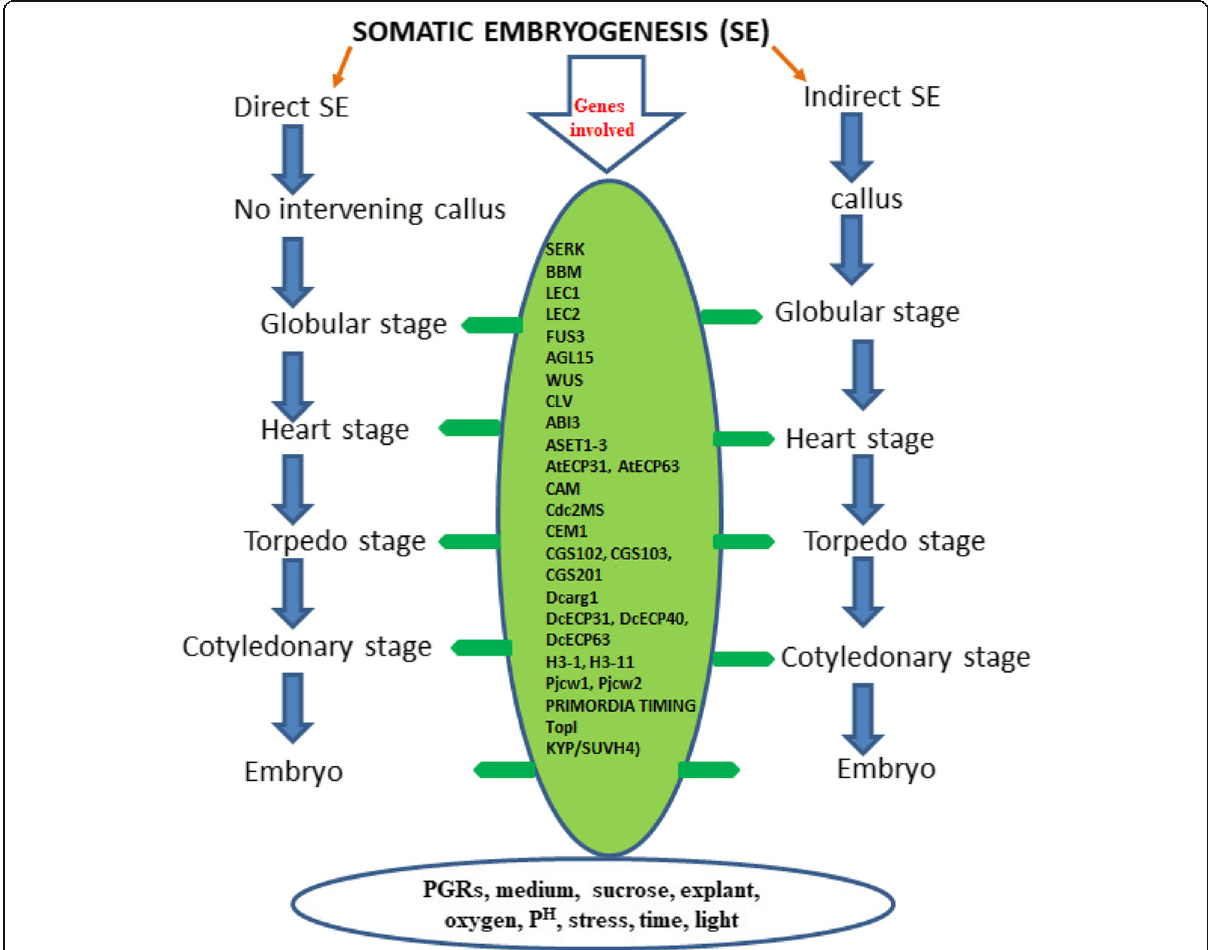
Fig. 1 Two different pathways of SE in dicots (i.e., direct and indirect SE), different (i.e., globular, heart, torpedo and cotyledonary) stages of embryos, factors affecting SE are kept at bottom in oval, and one central green oval shows some genes involved in SE. SERK1-5 ( SOMATIC EMBRYO RECEPTOR KINASE 1-5 ), LEC1, LEC2 ( LEAFY COTYLEDON 1,2 ), BBM ( BABY BOOM ), FUS3 ( FUSCA 3 ), ABI3(ABA INSENSITIVE 3 ), AGL15 ( AGAMOUS LIKE 15 ), ASET1-3 ( Alfalfa SE-specific transcripts ), AtECP31 ( Arabidopsis thaliana Embryogenic31 ), AtECP63 ( Arabidopsis thaliana Embryogenic63 cell proteins) , CaM genes ( Calmodulin genes ), Cdc2MS ( Cell division cycle ), CEM1 ( elongation factor-1 α ), CGS102, CGS103, CGS201 ( Carrot glutamine synthetase ), Dcarg1 ( Daucas carrotaauxin regulated gene ), SAUR ( small auxin up-regulated=Pjcw1 , Top1 ( topoisomerase1 ), DcECP31 , DcECP40 , DcECP63 ( Daucus carota embryogenic cell protein ), H3-1 , H3-11 ( Histone 3 ), KYP/SUVH4 ( Kryptonite ), LBD29 ( LATERAL ORGAN BOUNDARIES DOMAIN 29 ), PRC 1(POLYCOMB REPRESSIVE COMPLEX1